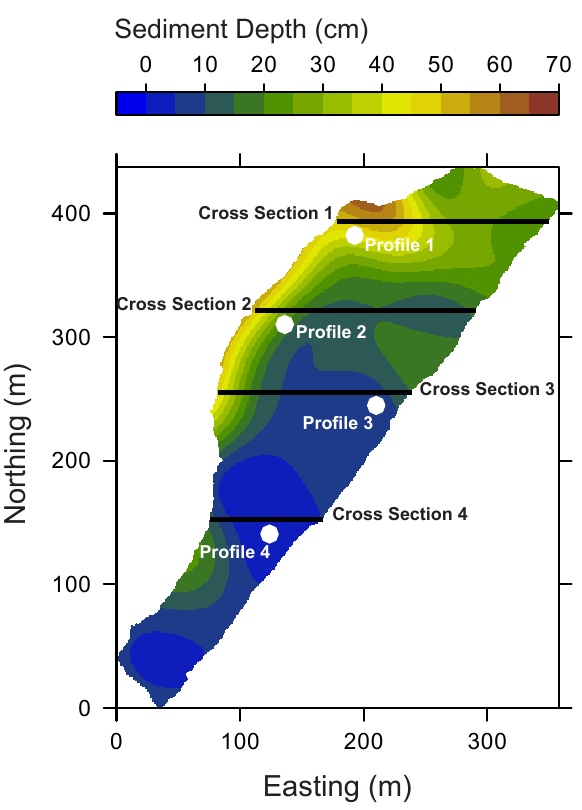
Fig. 8. Interpolation map showing the depth of sediment accumula- tion over 13 years in the northern section of the wetland, and sam- pling locations for sediment cross sections (1–4) and soil profiles